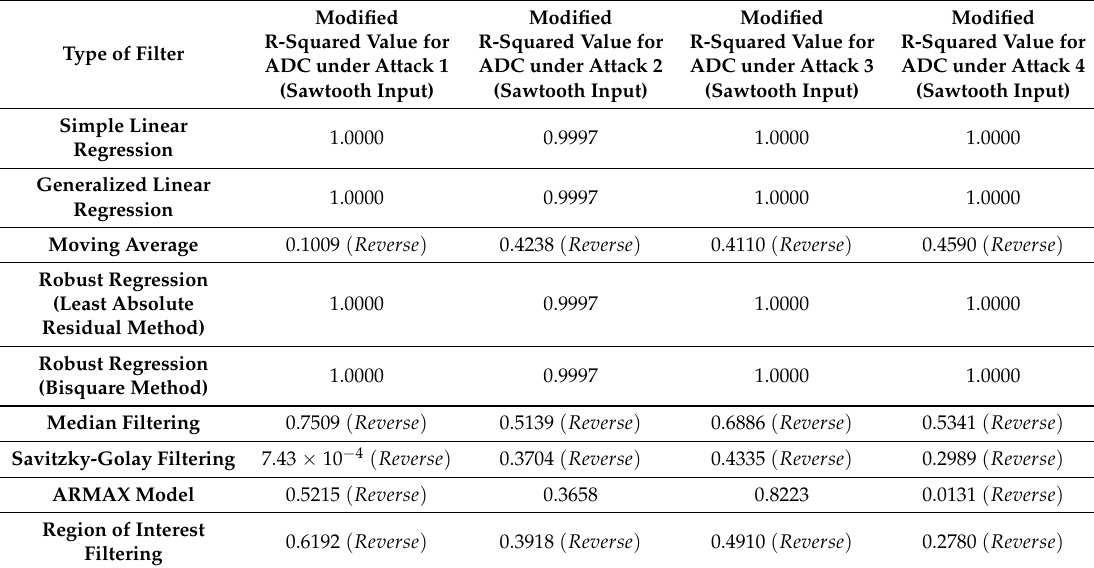
Table 3. Defense Analysis (3): The performance analysis of filters based on their corresponding modified R-squared values when a sawtooth signal is applied to the